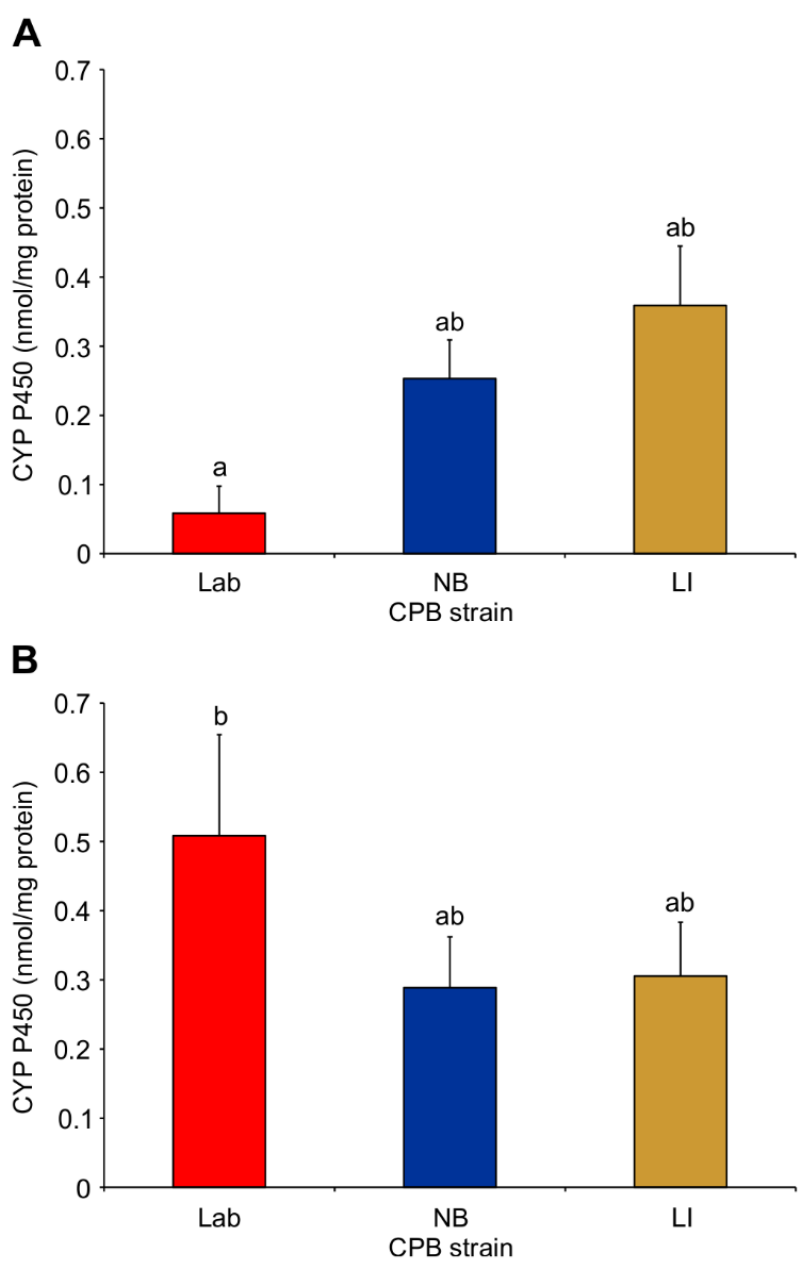
Figure 2. Mean cytochrome P450 activity in untreated ( A ) and imidacloprid-treated ( B ) Colorado potato beetle insecticide susceptible (Lab), tolerant (NB) and resistant (LI) strains. Bars with different lowercase letters between A and B are statistically different (Two-Way ANOVA (strain × treatment); Tukey’s pairwise comparison, p < 0.05).